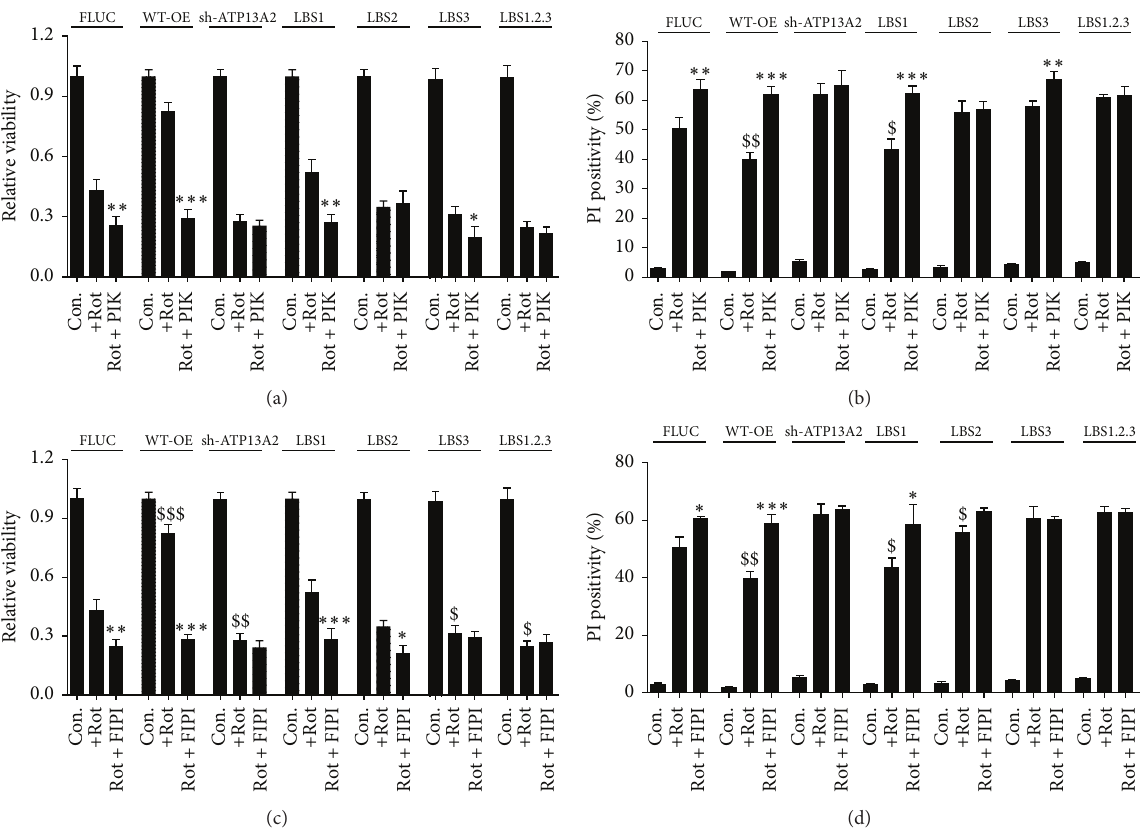
Figure 3: PA and PI(3,5)P2 mediated protection to mitochondrial stress occurs via ATP13A2. SHSY5Y cells stably expressing FLUC, shRNA for KD of ATP13A2, ATP13A2, and full length mutants of ATP13A2 with mutated putative lipid binding sites (LBS1–3) were exposed to rotenone (Rot, 1 𝜇 M) in the presence or absence of 1h pretreatment with the pharmacological inhibitors of PIKfyve lipid kinase (((a) and (b)) YM-201636, 200 nM) or phospholipase D (((c) and (d)) FIPI, 100 nM). Following 24 h exposure to rotenone, cells were assessed for cell viability ((a) and (c)) or death ((b) and (d)) by, respectively, MUH and propidium iodide (PI) assays. Data are the mean of 3 independent experiments ± SD. $ statistical differences between FLUC and WT-OE/sh-ATP13A2/LBS1/LBS2/LBS3/LBS1.2.3, ∗ statistical differences within cell line following treatment with inhibitor (1 mark, 𝑃 < 0.05 ; 2 marks, 𝑃 < 0.01 ; 3 marks, 𝑃 < 0.001 ) (ANOVA with Bonferroni post hoc